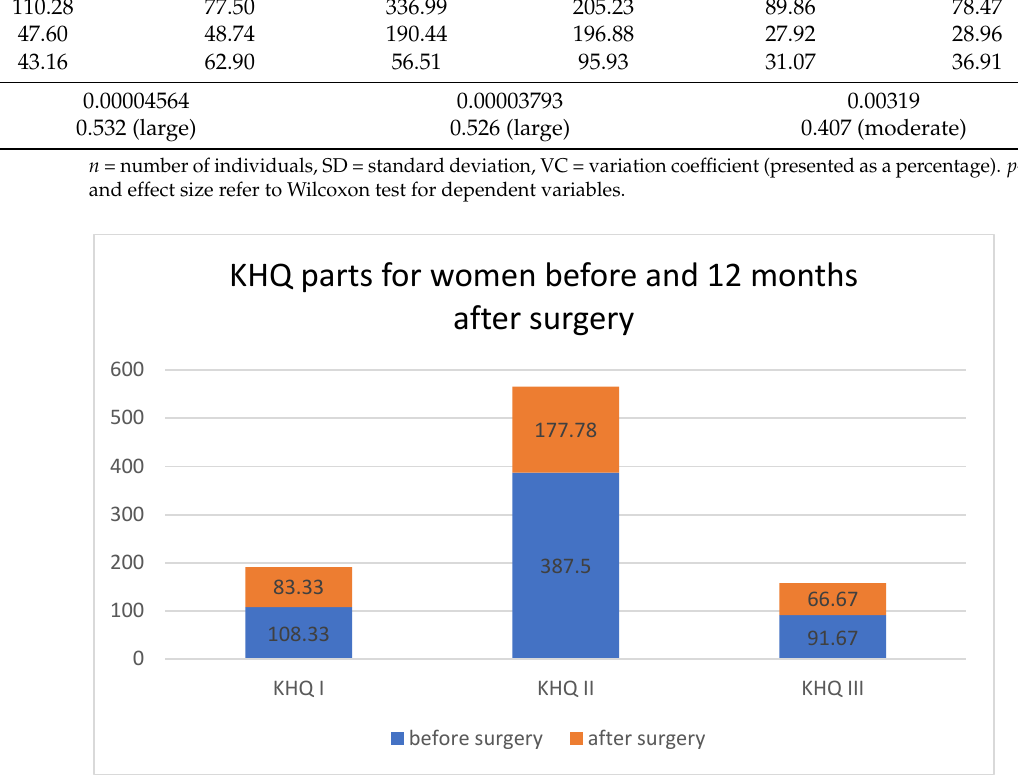
Figure 3. KHQ parts for women before and 12 months after surgery. Medians differing in Part I, Part II and Part III of the King ’ s Health Questionnaire (KHQ) before and 12 months after surgery.